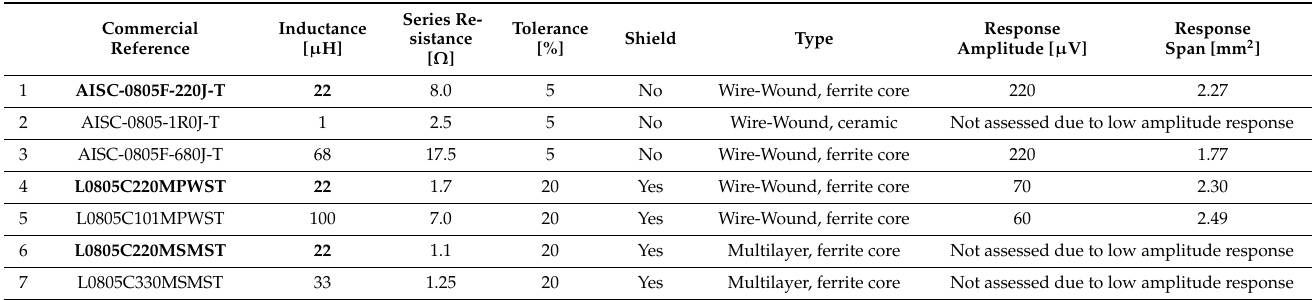
Table 1. Evaluated commercial SMD coils.